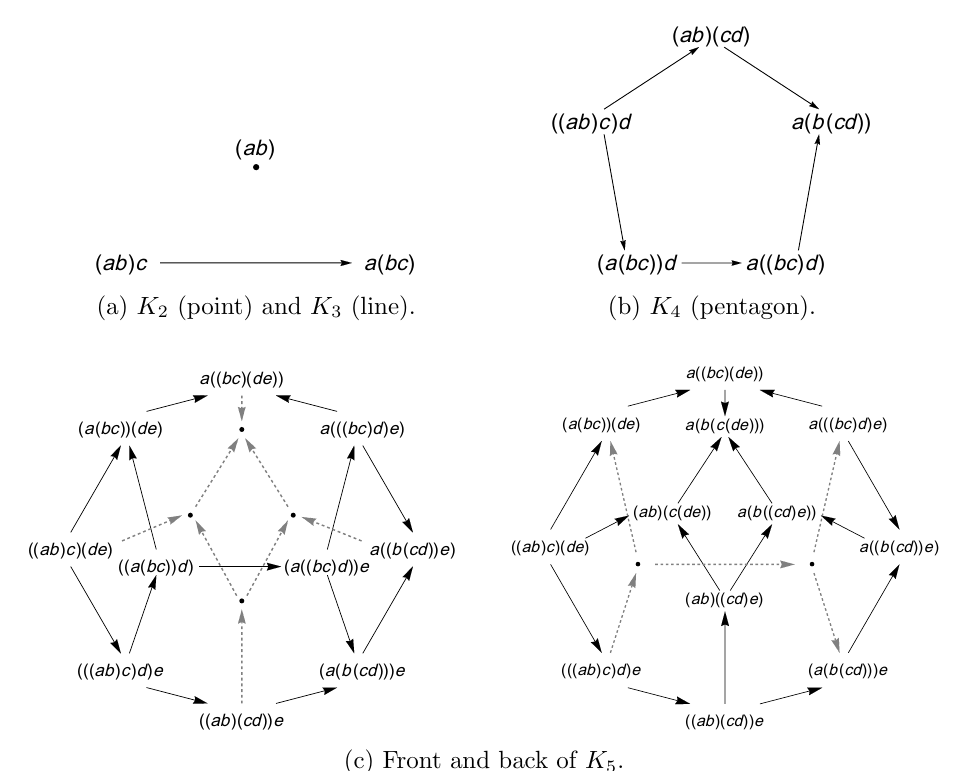
Figure 1 . The associahedra K 2 , K 3 , K 4 and K 5